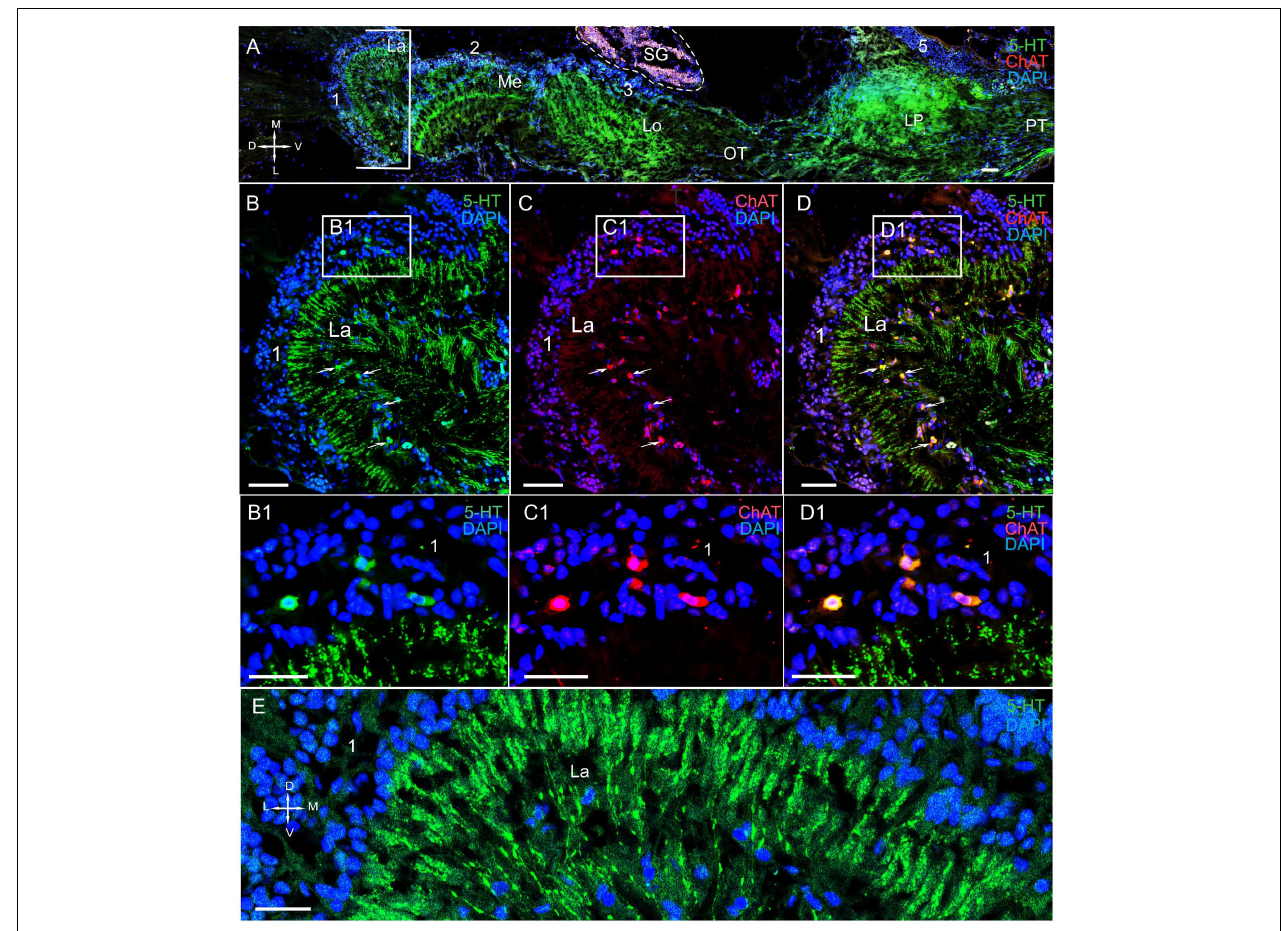
FIGURE 3 | Immunolocalization of 5-HT and ChAT in the lamina of Paralithodes camtschaticus . (A) Horizontal section through an eyestalk showing positive immunostaining for ChAT and 5-HT in the optic neuropils, SG, and LP. (B–D) Detection of ChAT and 5-HT in cell cluster 1 above and below the plexiform layer of